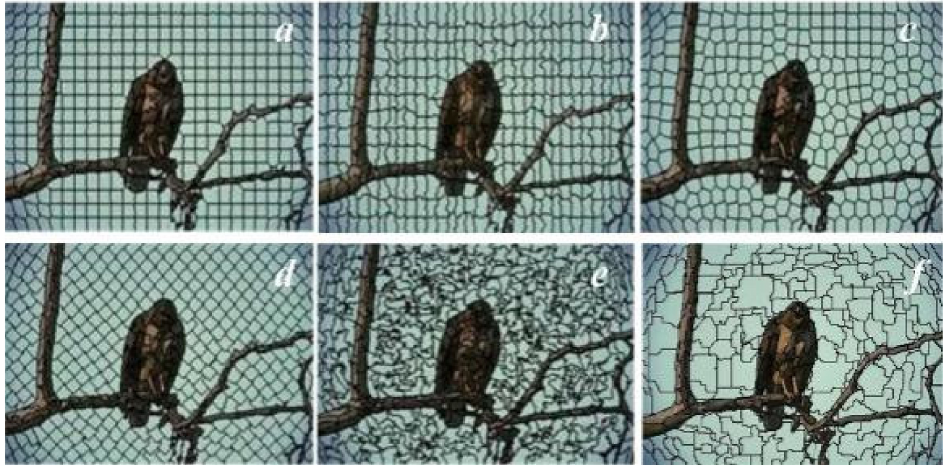
Figure 1. The six typical superpixel segmentation results. ( a ) SLIC [6], ( b ) PB [14], ( c ) LSC [8], ( d ) DBSCAN [11,12], ( e ) ERS [9], ( f ) SEEDS